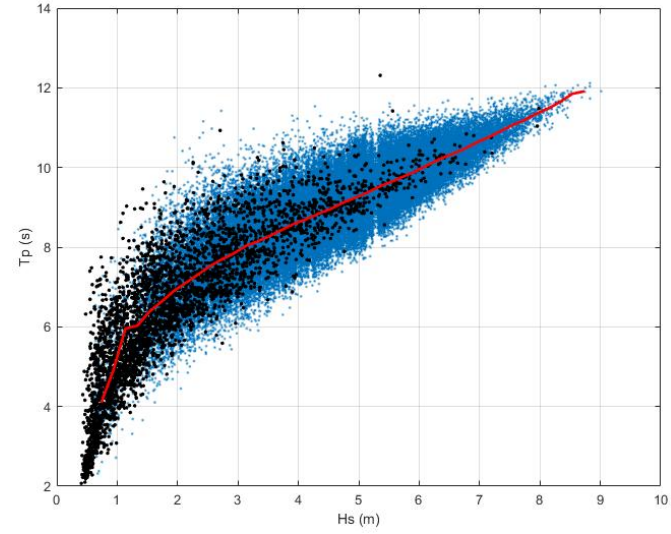
Figure 6. Relationship between Tp and Hs: declustered data (black dots), Monte Carlo simulation